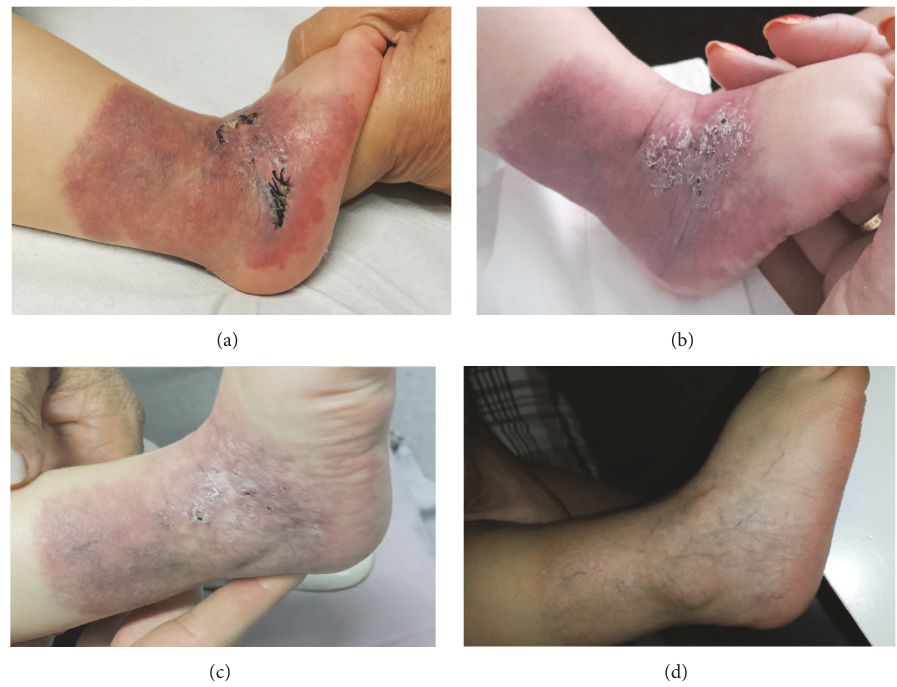
Figure 2: Case 2. (a) A skin biopsy on erythematous scaly plaque with geometric border covering all lateral aspect of her right ankle as a sock-like distribution. (b) Numerous superficial ulcerations of this erythematous scaly plaque. (c) Progressive regression of the lesion and the ulceration with propranolol treatment. (d) Spontaneous involution of the lesion.